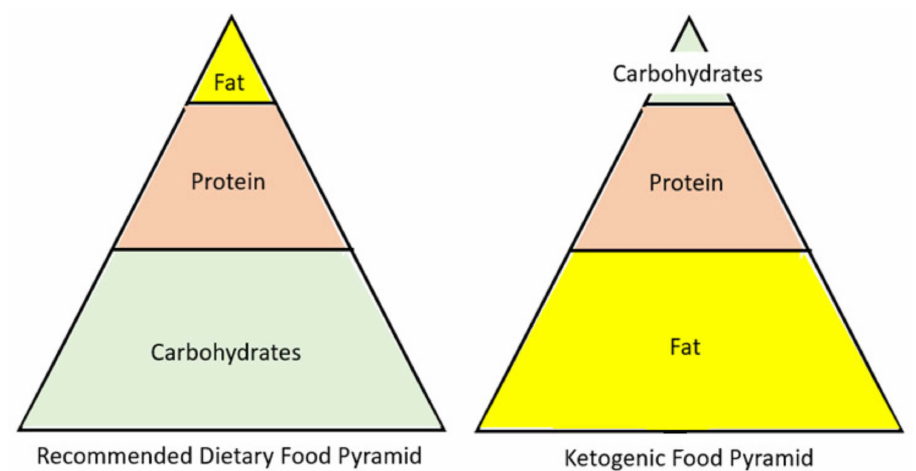
Figure 2. A visual comparison of the recommended dietary food pyramid, including major macro- molecule components, to the ketogenic diet food pyramid.